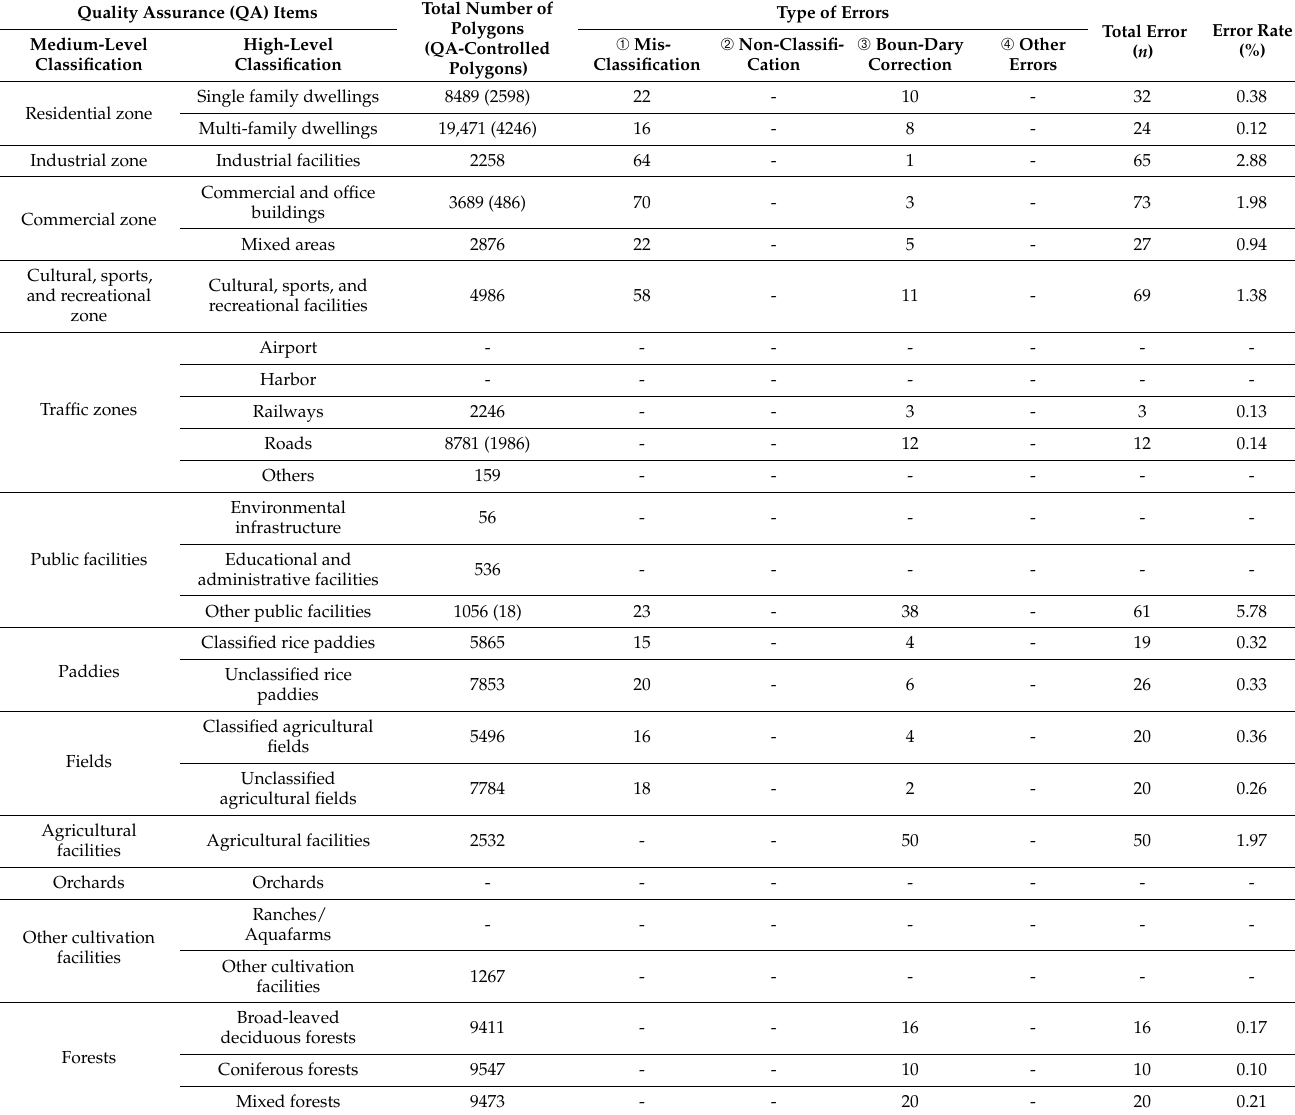
Table 4. Error detection table for the detailed landcover map update